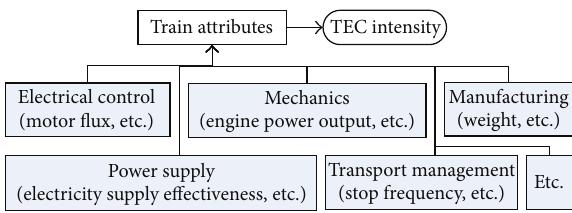
Figure 4: Attribute improvement for TEC intensity